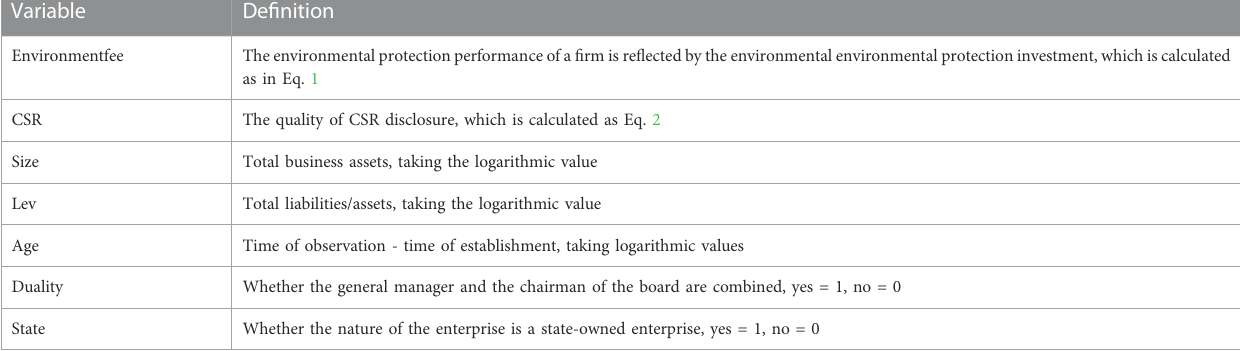
TABLE 1 The de fi nition of